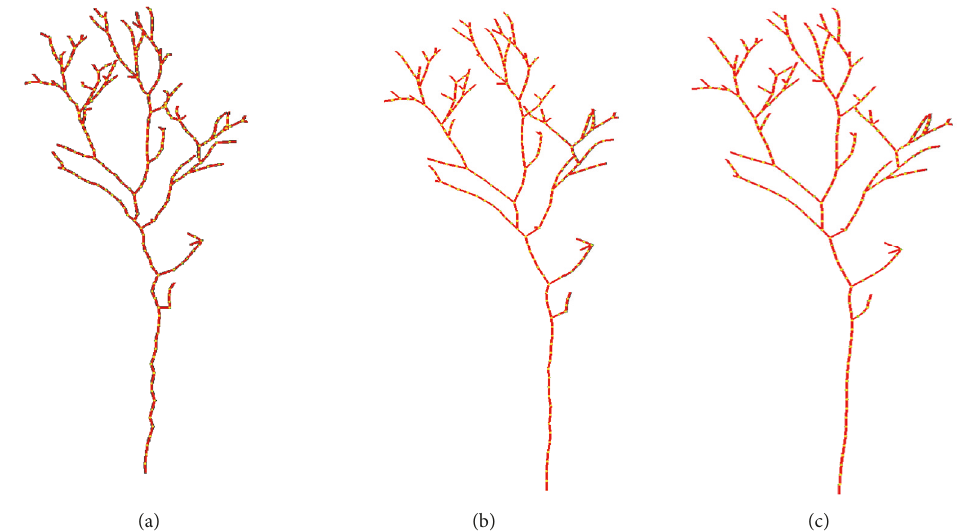
Figure 11: The result of smoothing. (a) is the skeleton of the original data, (b) is the skeleton obtained after a smoothing process, and (c) is the skeleton that is smoothed again.